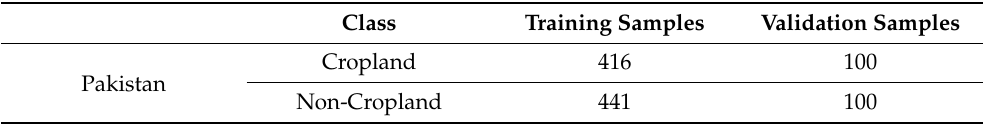
Figure 3. Sub-meter to 10 m image details with a relatively good resolution for Pakistan. Illustration of Pakistan’s comparison training data obtained using high-resolution imagery sub-meter to 10 m. Table 3 describes the distribution of the comparison training and validation results. Table 3. Education and confirmation details on sources. A collection of comparison samples used by machine-learning algorithms and the number of testing samples required to determine autonomous